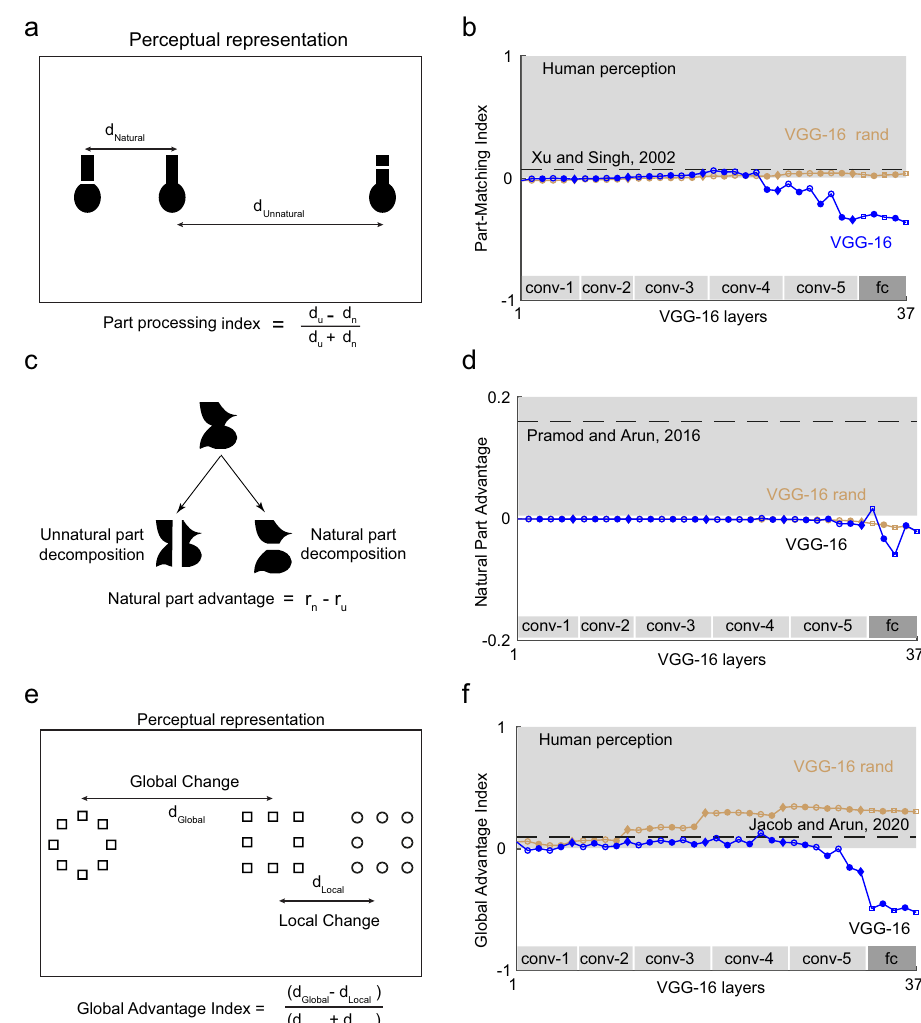
Fig. 6 Part-whole relations in deep networks. a Schematic showing the perceptual representation of objects with a break introduced either at natural or unnatural part cuts. b Part processing index across layers of the VGG-16 network ( blue ) and VGG-16 with random weights ( brown ). The dashed line represents the effect size estimated from human visual search on the same stimuli 30 . c Schematic showing how the same object can be broken into either natural or unnatural parts. The natural part advantage is calculated as the difference in correlation between part-sum models trained to predict whole- object dissimilarities using the parts (see he “ Methods ” section). d Natural part advantage across layers of the VGG-16 network ( blue ) and VGG-16 with random weights ( brown ). The dashed line represents the effect size estimated from human visual search on the same stimuli 31 . e Perceptual representation of hierarchical stimuli. The left and middle images differ only in global shape whereas the middle and right images differ only at the local level. According to the global advantage effect, a change in global shape is more salient than a change in local shape. f Global advantage index across layers of the VGG-16 network ( blue ) and VGG-16 with random weights ( brown ). The dashed line represents the effect size estimated from human visual search on the same stimuli 63